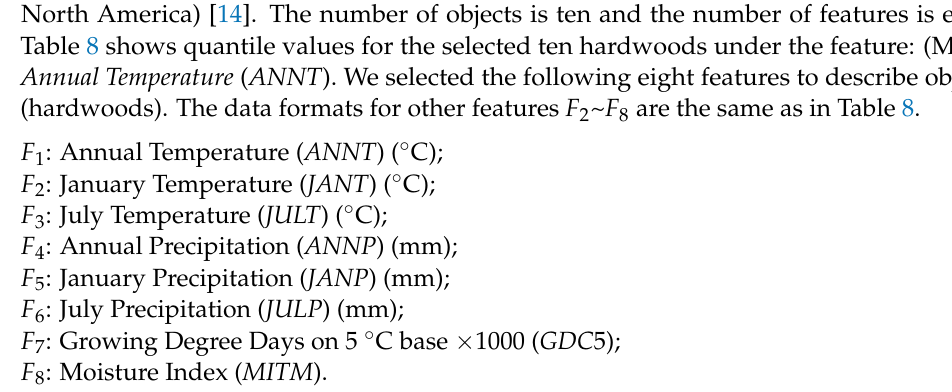
Table 8. The original quantile values for ANNT.